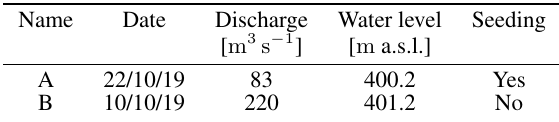
Table 1. Summary of the characteristics of the two datasets. 1 (cid:48)(cid:48) CMOS sensor, mounted on a three-axis gimbal. The focal length was 8 . 8 mm and the image size was 4096 × 2160 px . The take-off weight of the UAV was 1 . 4 kg and the total cost of quad-copter and accessories was below 2,000 e (March 2018). Video A was 35 s long and was acquired with a frame rate of 29 . 97 Hz (1048 frames); video B had a duration of 30 s and a framerate of 23 . 97 Hz (718 frames).